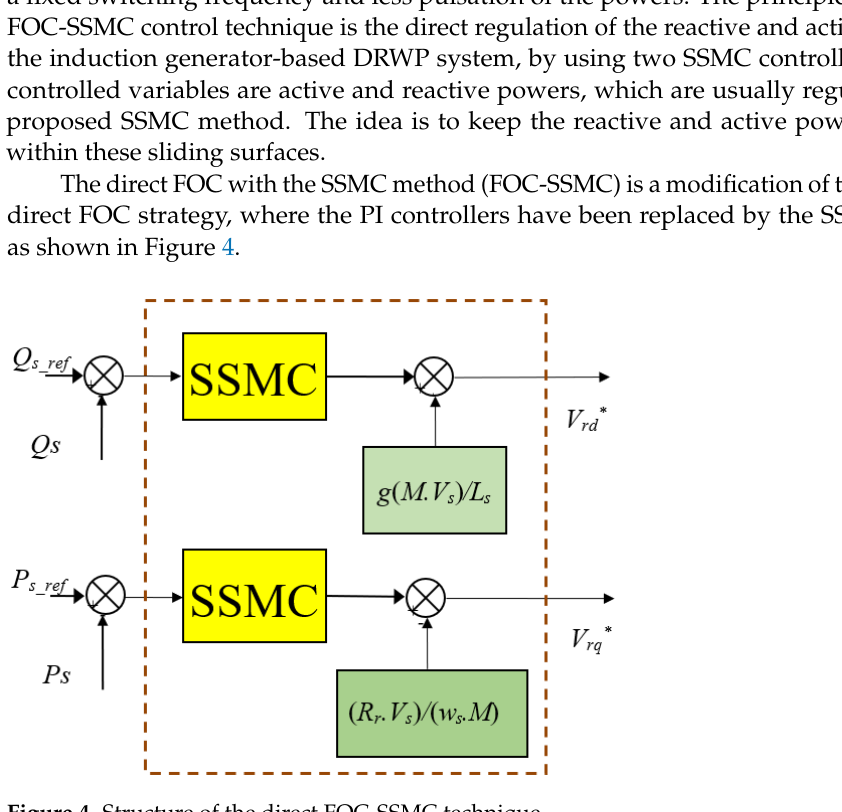
Figure 3. Classical direct FOC technique.